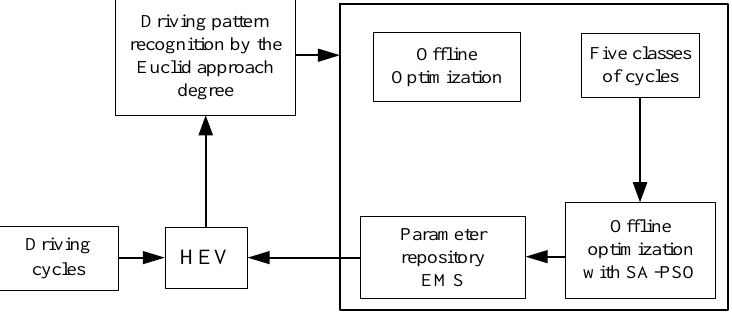
Figure 8. Diagram of EMS based on driving pattern recognition.